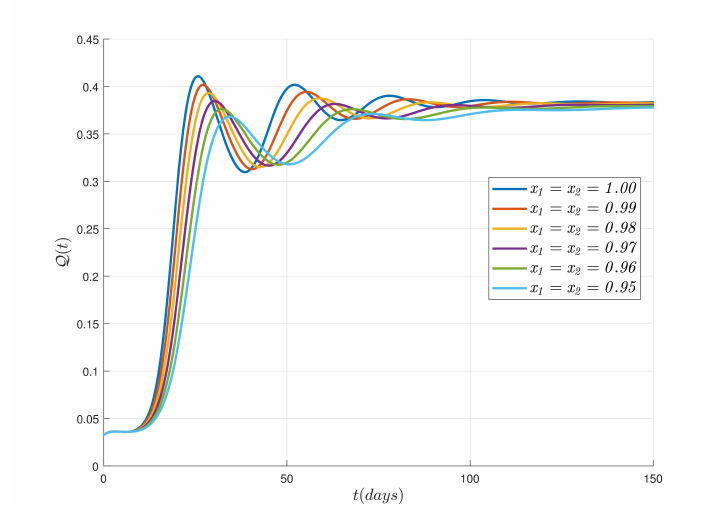
Figure 5. Behaviors of H ( t ) .